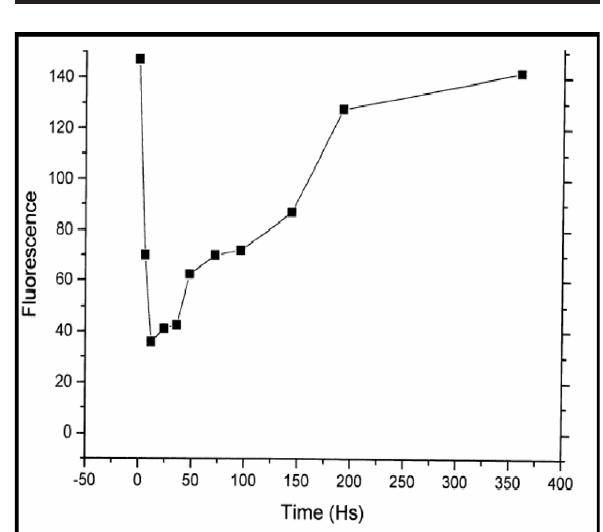
FIGURE 8 - The evolution a figure of merit extracted from the spectra, with the waiting time after partial